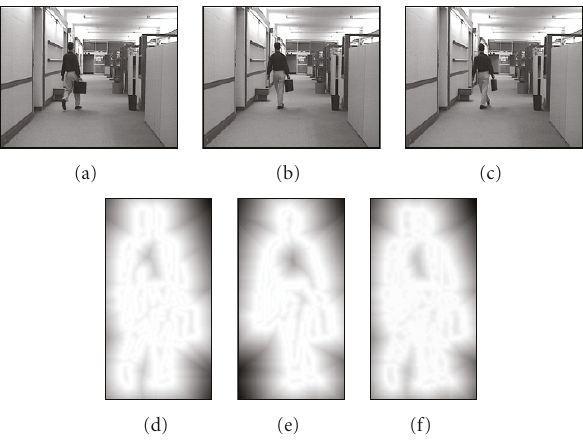
Figure 3: Illustration of advantage in using DT n for matching. (a) I n − 1 ; (b) I n ; (c) I n +1 ; (d) DT n − 1, n ; (e) DT n , n +1 ; (f) DT n